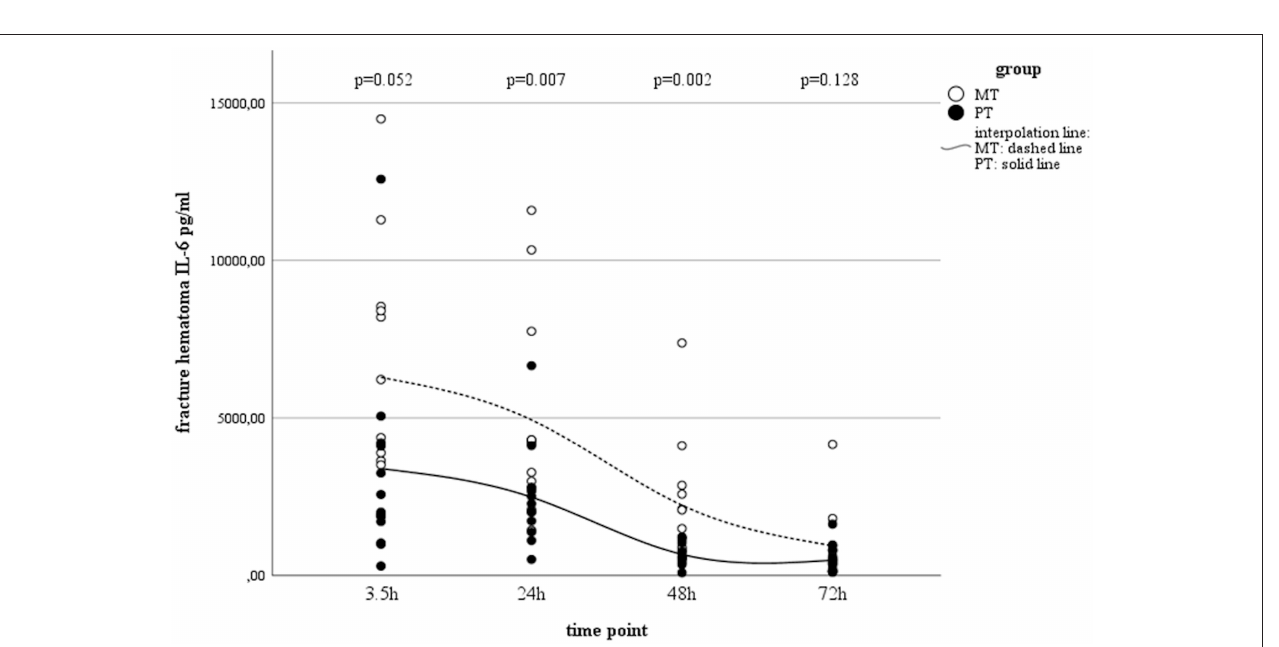
this finding in MT was statistically not significant ( Table 2